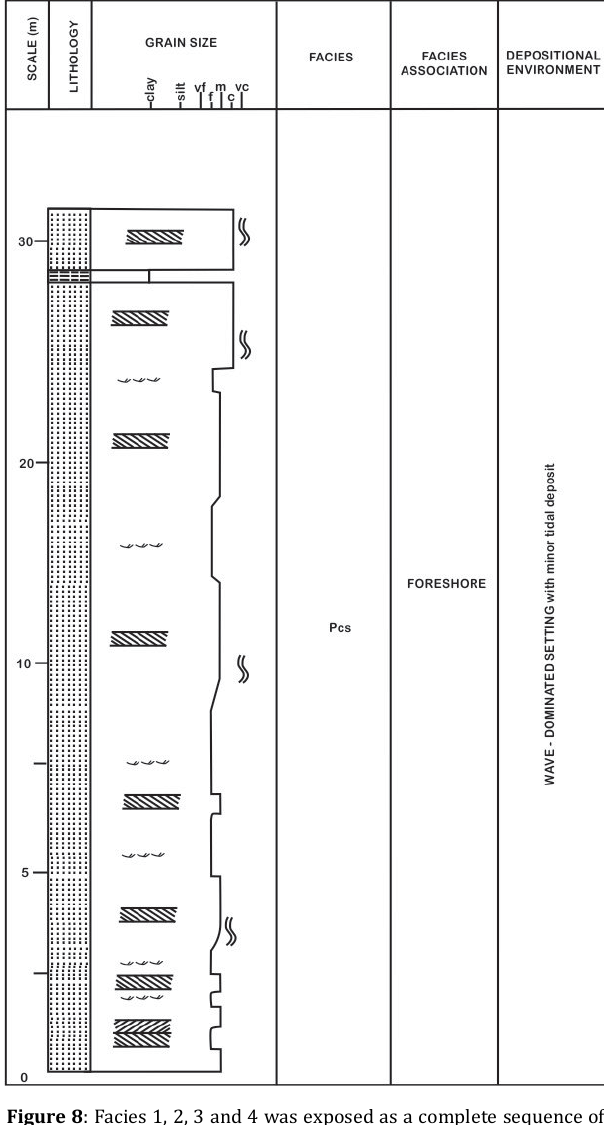
Figure 8 : Facies 1, 2, 3 and 4 was exposed as a complete sequence of facies located at Oil Well outcrop.